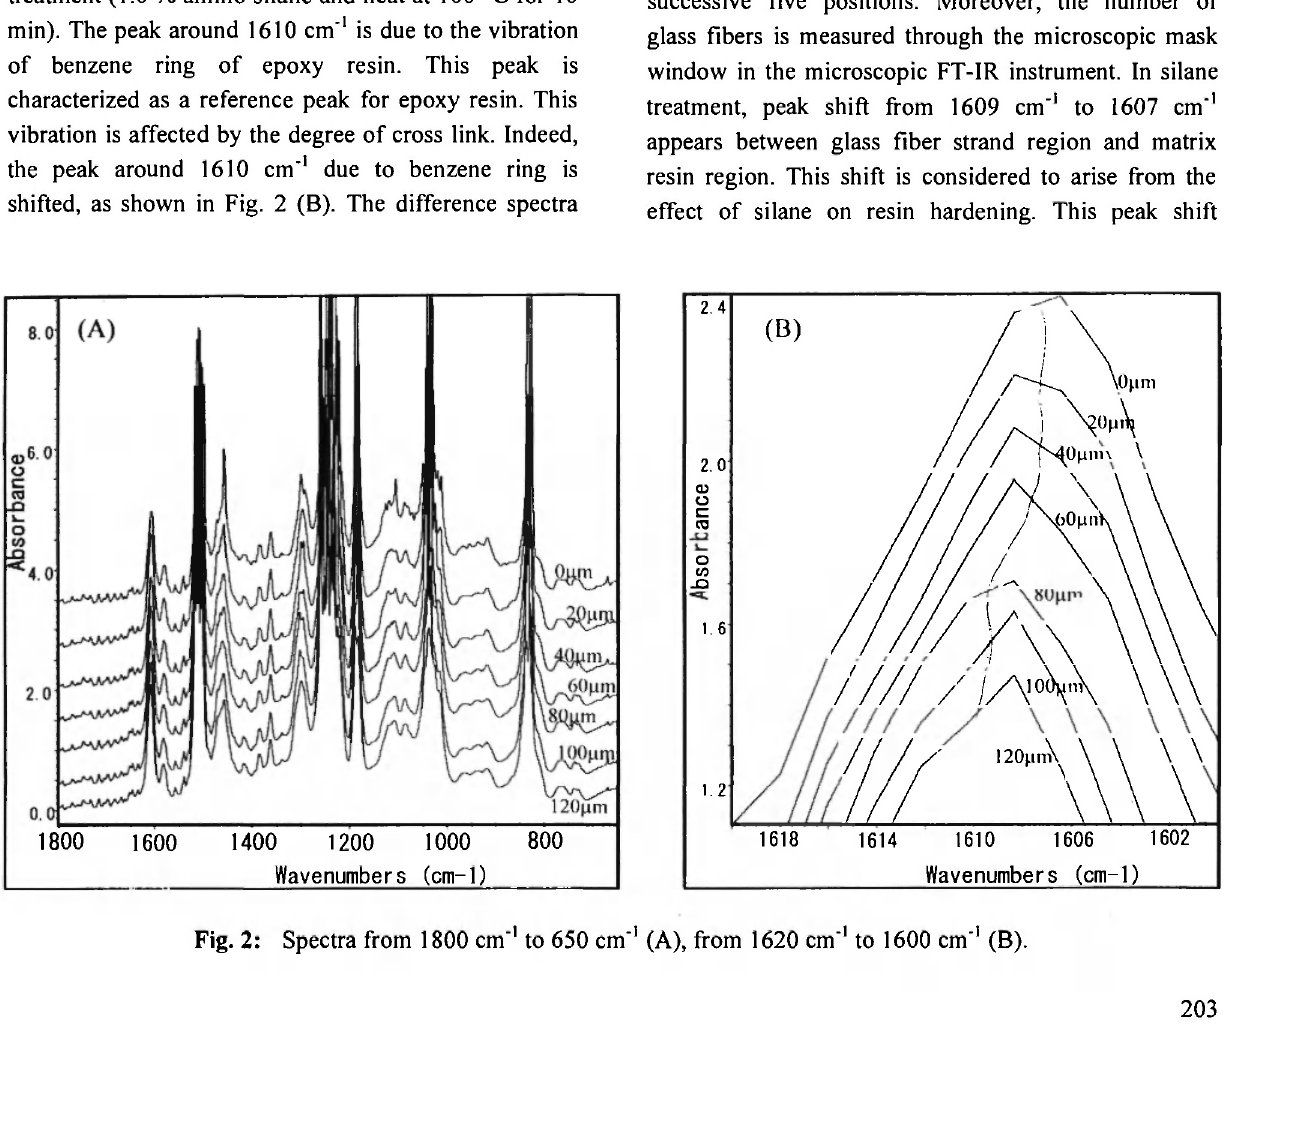
Fig. 2: Spectra from 1800 cm" 1 to 650 cm" 1 (A), from 1620 cm"' to 1600 cm" 1 (B).